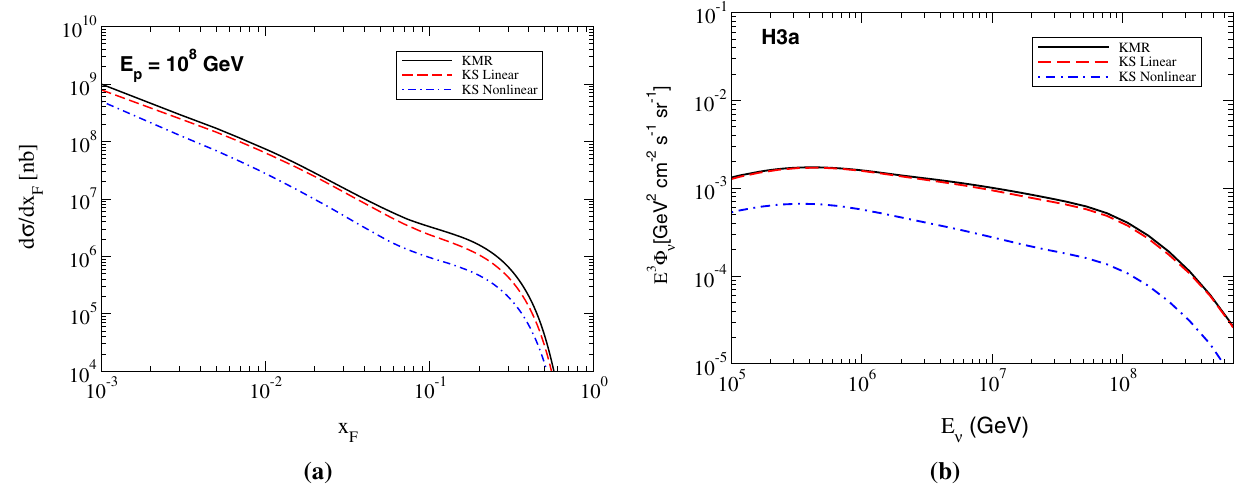
Fig. 8 Predictions of the hybrid model for the a Feynman x F -distributions for charm particles and b the prompt neutrino flux (rescaled by E 3 ν ), derived assuming different models for the uPDF. The H3a prametrization of the cosmic ray flux is used in this calculation